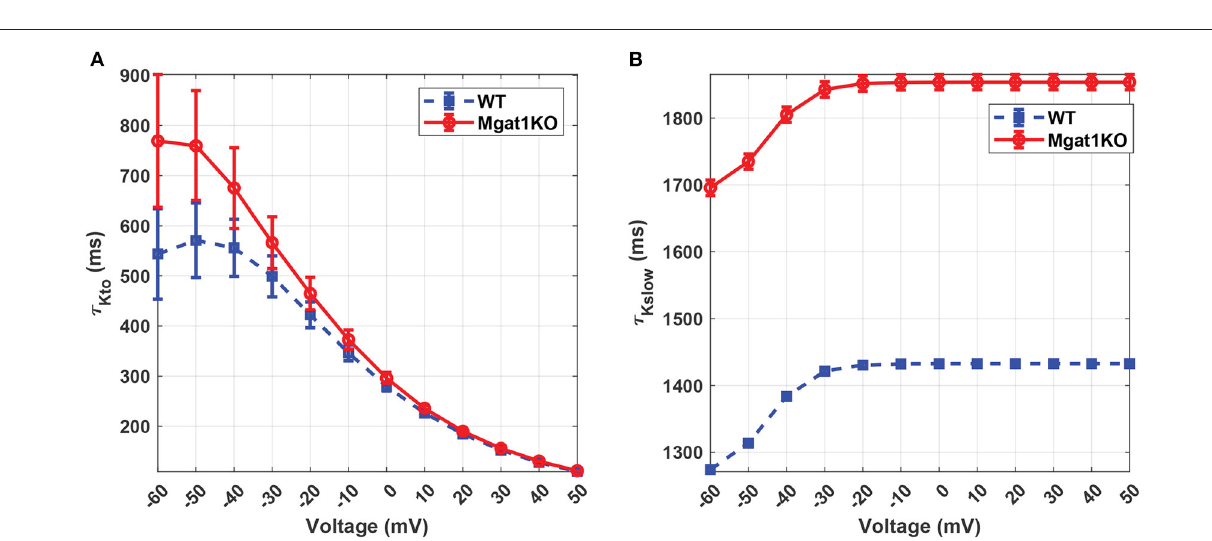
FIGURE 7 | Predicted inactivation time constants to voltage relationship under the WT and Mgat1KO conditions. (A) I Kto . (B) I Kslow . Voltage steps range from -60 to 50 mV by 10-mV